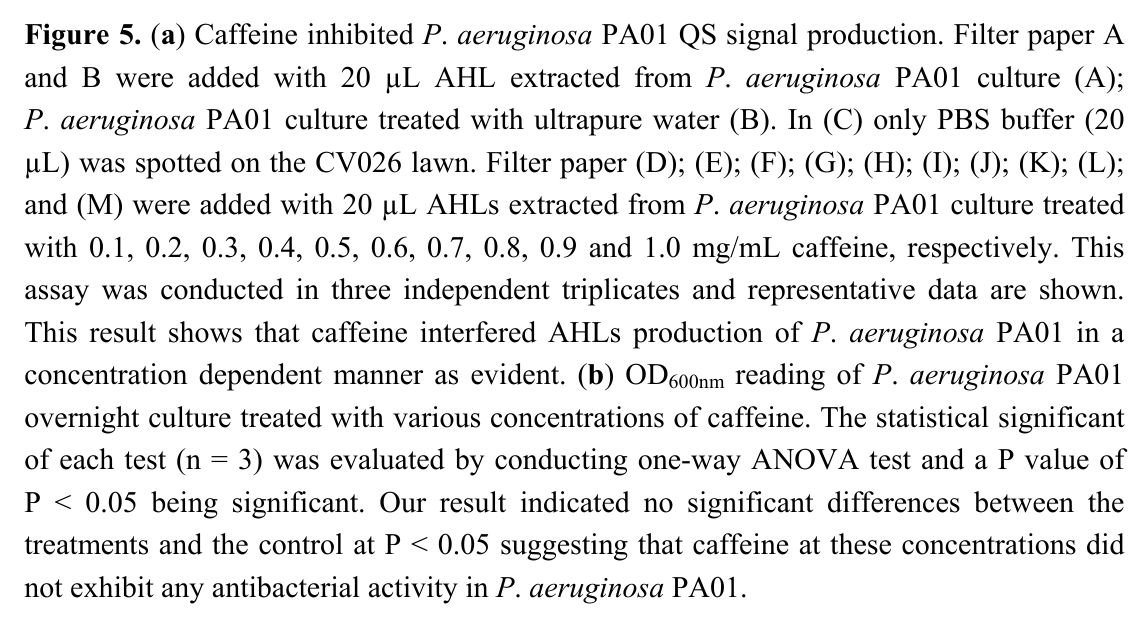
Figure 5. ( a ) Caffeine inhibited P . aeruginosa PA01 QS signal production. Filter paper